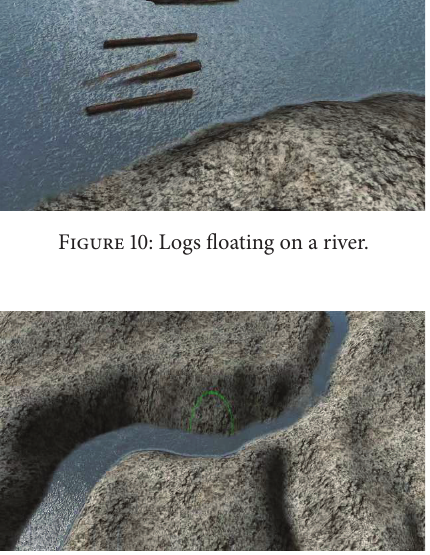
Figure 11: A free flowing river before building a